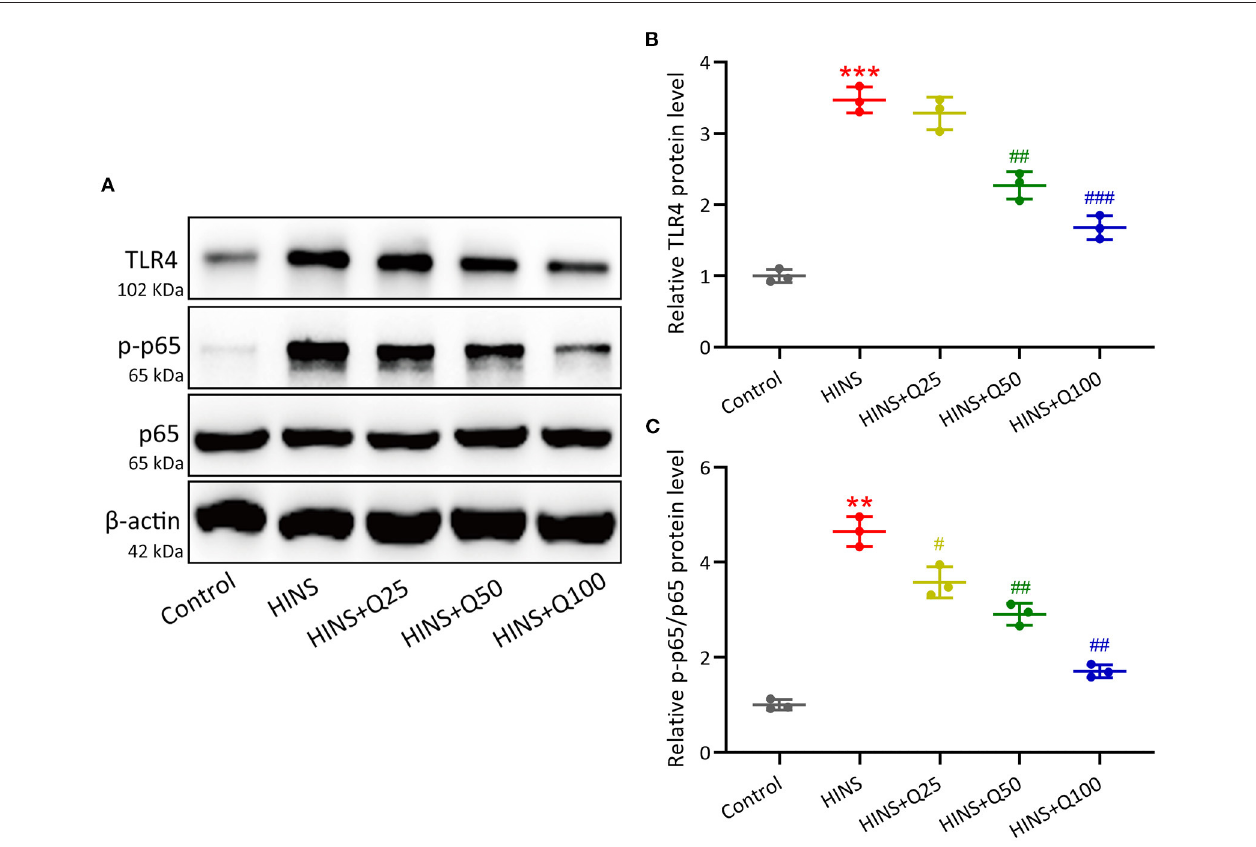
FIGURE 6 | Quercetin administration following HINS down-regulated hippocampal TLR4/NF- κ B signaling. The hippocampal protein expressions of TLR4, p-p65, and p65 (A) were measured by western blotting. The expressions were normalized to control (B,C) . Three rats were used in each group. Mean ± SD. ** p < 0.01, *** p < 0.001 compared to control. # p < 0.05, ## p < 0.01, and ### p < 0.001 compared to HINS.